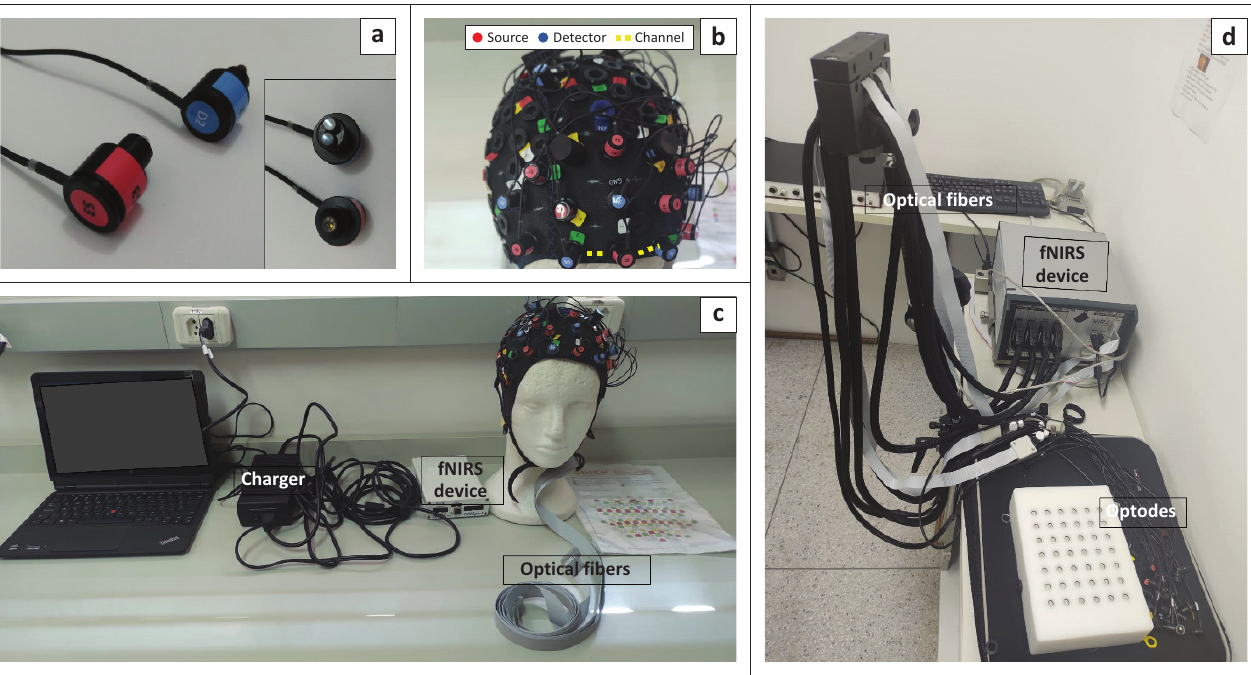
FIGURE 3: An example of functional near-infrared spectroscopy (fNIRS) device: (a) A pair of optodes. The red label represents a light source and the blue label represents the light detector. (b) An example of a prefrontal arrangement of the optodes (which is called montage). Note that the yellow dots represent a channel. (c) A portable, battery-operated fNIRS device with the hardware needed to perform an fNIRS data acquisition. The computer used to monitor the brain signals online is close to the fNIRS charger. Depending on the experimental task, an additional computer may be needed for task presentation. Note that the appearance of fNIRS devices might be quite differentiable depending on the company. (d) A non-portable fNIRS system, which is usually bigger than the portable